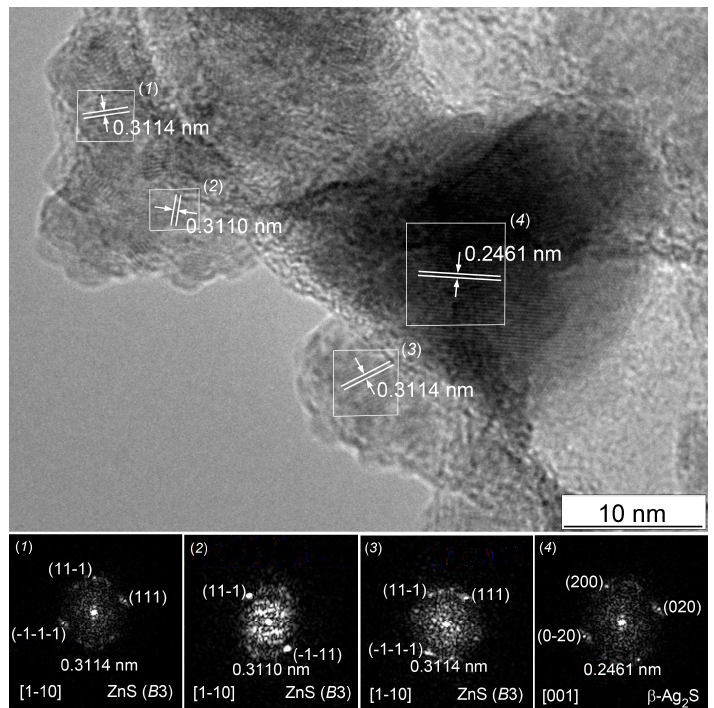
Figure 20. HRTEM image of (Ag 2 S) 0.1 (ZnS) heteronanoparticle. Reprinted with permission from Ref. [84]. 2022, Elsevier. The bottom row shows the electron diffraction patterns obtained by Fast Fourier Transformation (FFT) of selected areas ( 1 )–( 4 ) of HRTEM image. The interplanar distance of ~0.311 nm for selected areas ( 1 )–( 3 ) corresponds to the interplanar distance between the atomic planes (111) of cubic (space group F 43 m ) ZnS. The interplanar distance ~0.246 nm of selected area ( 4 ) coincides with the distance between the atomic planes (200) of cubic (space group Im 3 m ) β -Ag 2 S silver sulfide.